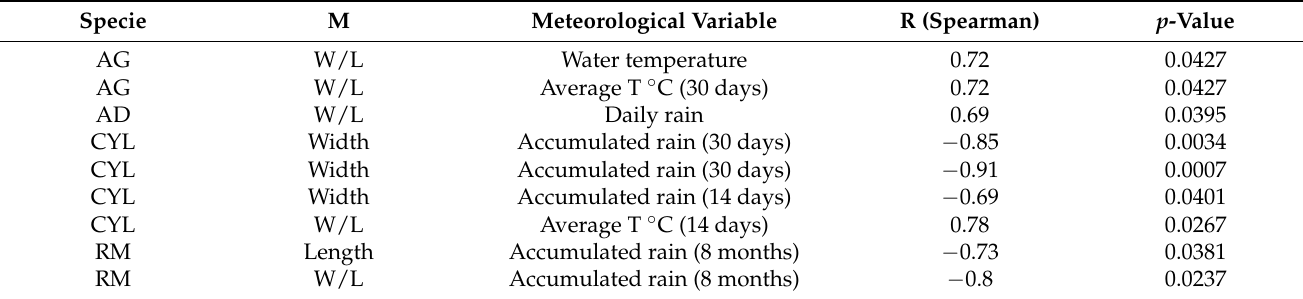
Table 3. Spearman correlations between physical, chemical, and meteorological variables with the morphological variables of AD ( Aphanocapsa delicatissima) , AG ( Aphanizomenon gracile) , RM (Raphidiopsis mediterranea ), and CYL ( Cylindrospermopsis raciborskii